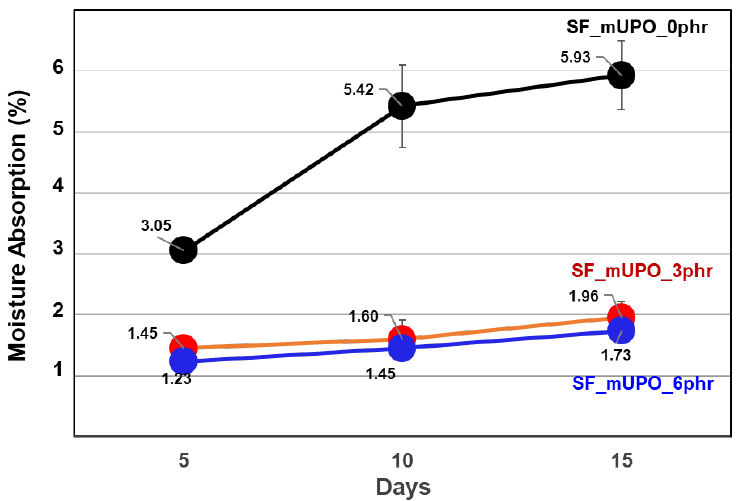
Figure 3. The moisture absorption at 70% relative humidity of non-glutinous starch foam with var- ious mUPO content — 0, 3, and 6 phr. various mUPO content—0, 3, and 6